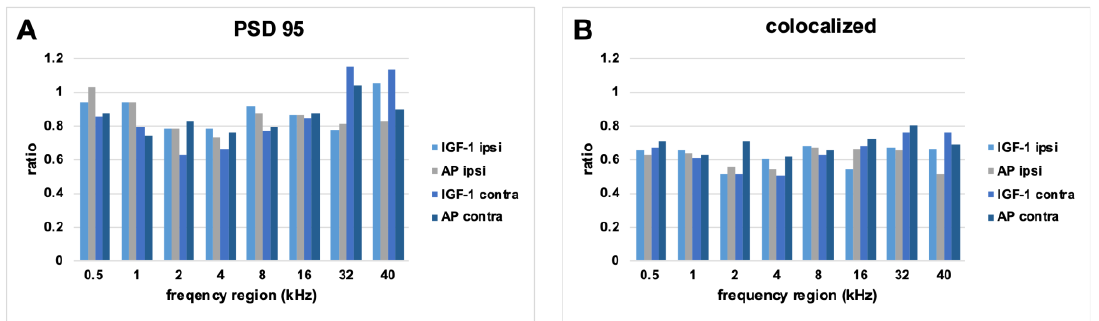
Figure 9. Ratio of mean values of PSD95 ( A ) and colocalized ( B ) points to CtBP2 counts for each condition. The mean CtBP2 counts for each condition was set as 1.